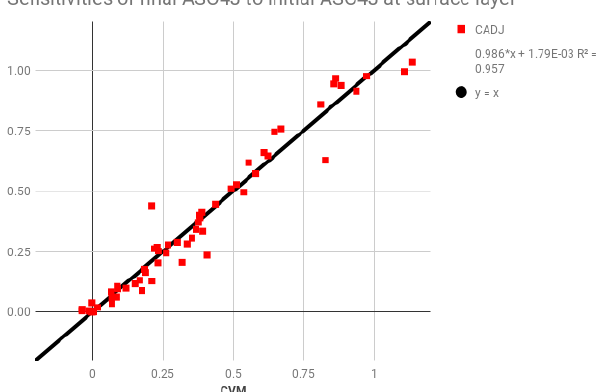
Figure 12. Evaluation of advection with the CADJ (continuous ad- joint) against the CVM (complex variable method) sensitivities of the final concentrations of an accumulation-mode aerosol species ASO4J (µgm − 3 ) with respect to the initial ASO4J (µgm − 3 ) from a 1d test run. The perturbation size for the CVM is